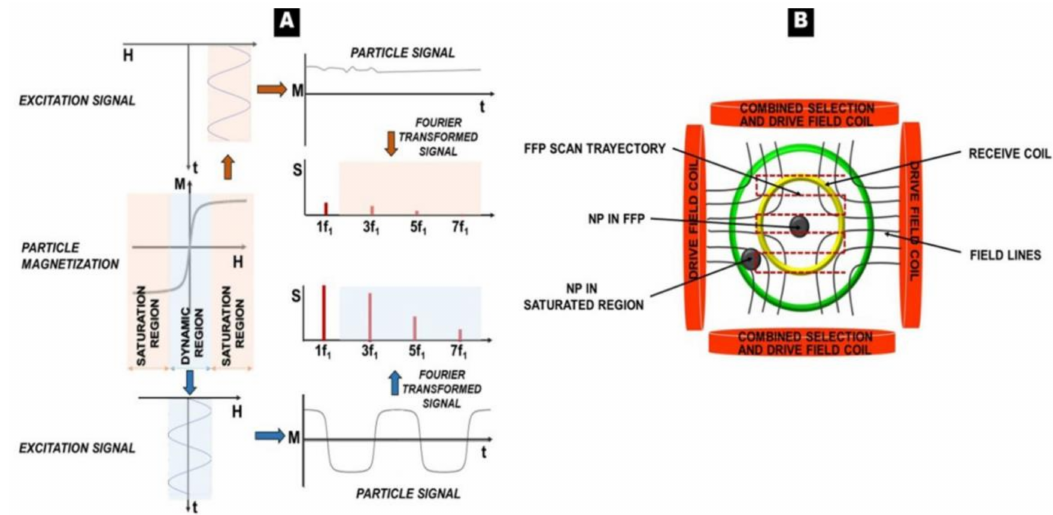
Figure 15. MPI basic concepts. ( A ) Response of SPIONs in dynamic and saturation regions and respective particle and electromagnetic signals; ( B ) scheme of an MPI scanner. Adapted with permission from [15], Copyright 2021 Elsevier